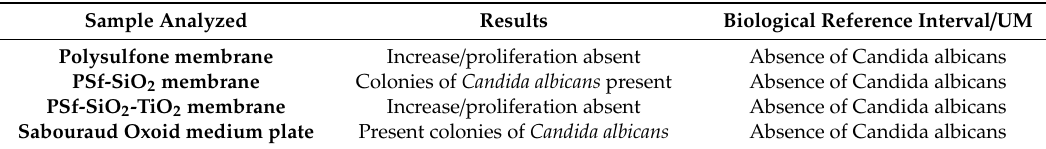
Table 7. Bacteriological analysis results for Candida albicans ATCC 10231 strain.